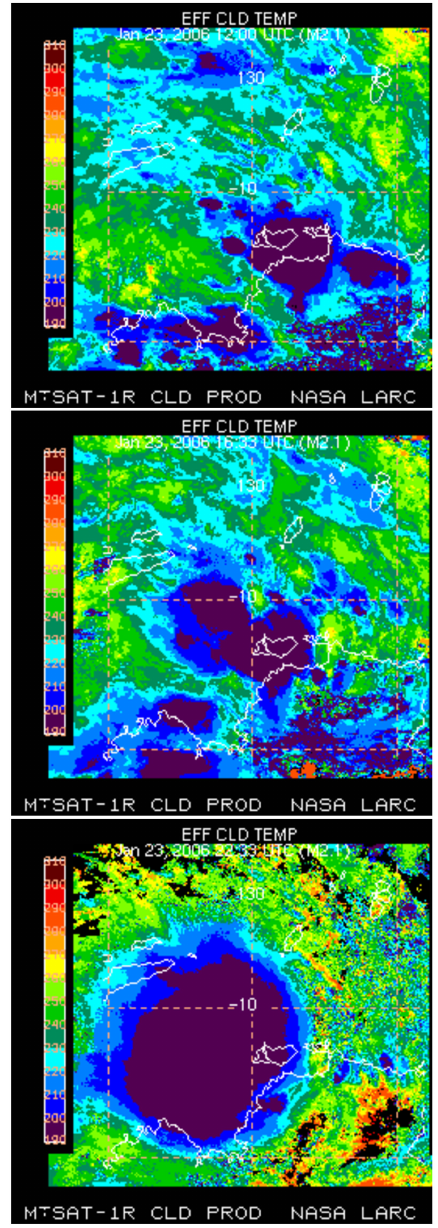
Figure 7. Cloud top temperature derived from MTSAT-1R at 12:00, 16:33, and 22:33UTC on 23 January 2006 over Darwin. The darkest shade is colder than 200K, overlying a region that includes the Tiwi Islands in each